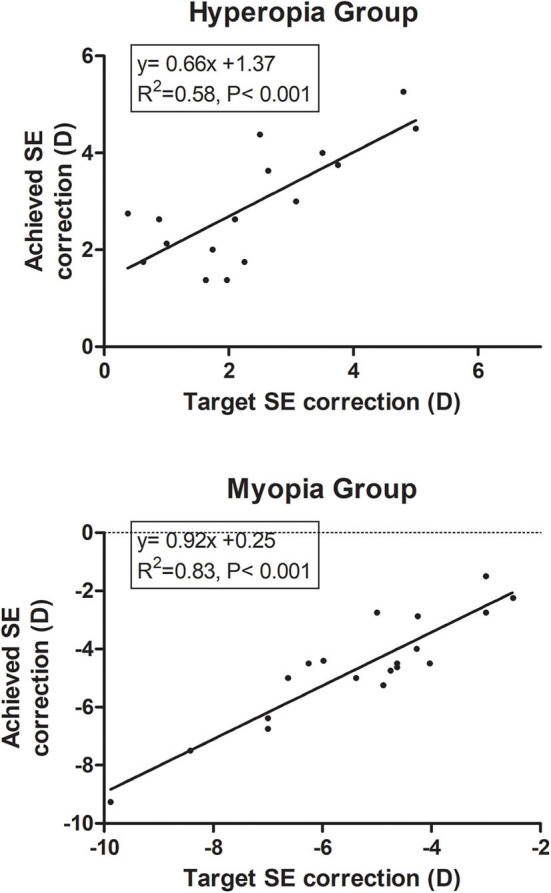
Predictability of spherical equivalent correction.